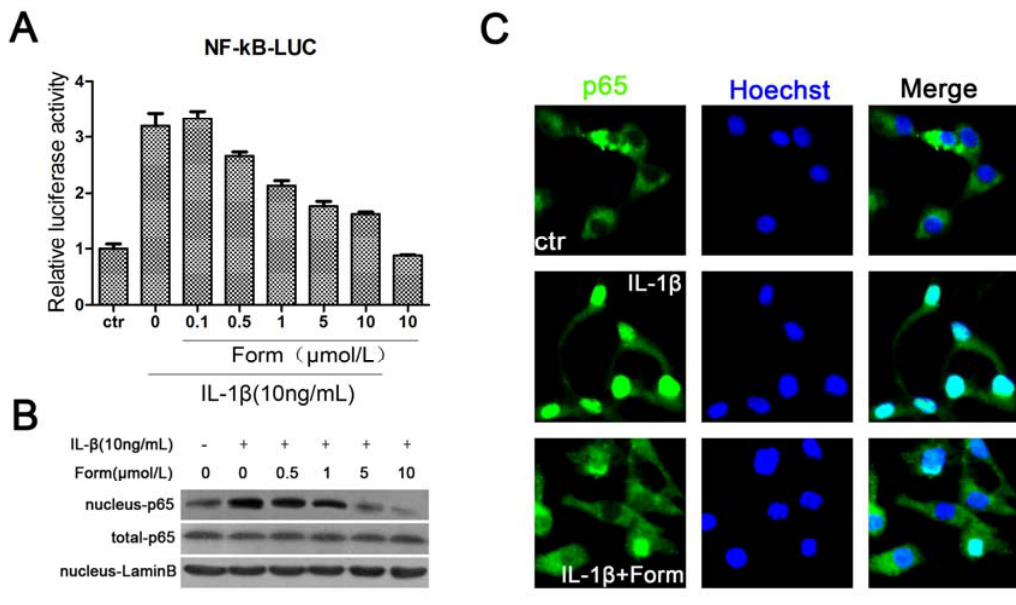
Figure 2. The effect of formononetin on IL-1 β -induced activation of NF- κ B in INS-1cells. Cells were treated with the indicated concentrations of IL-1 β and formononetin for 24